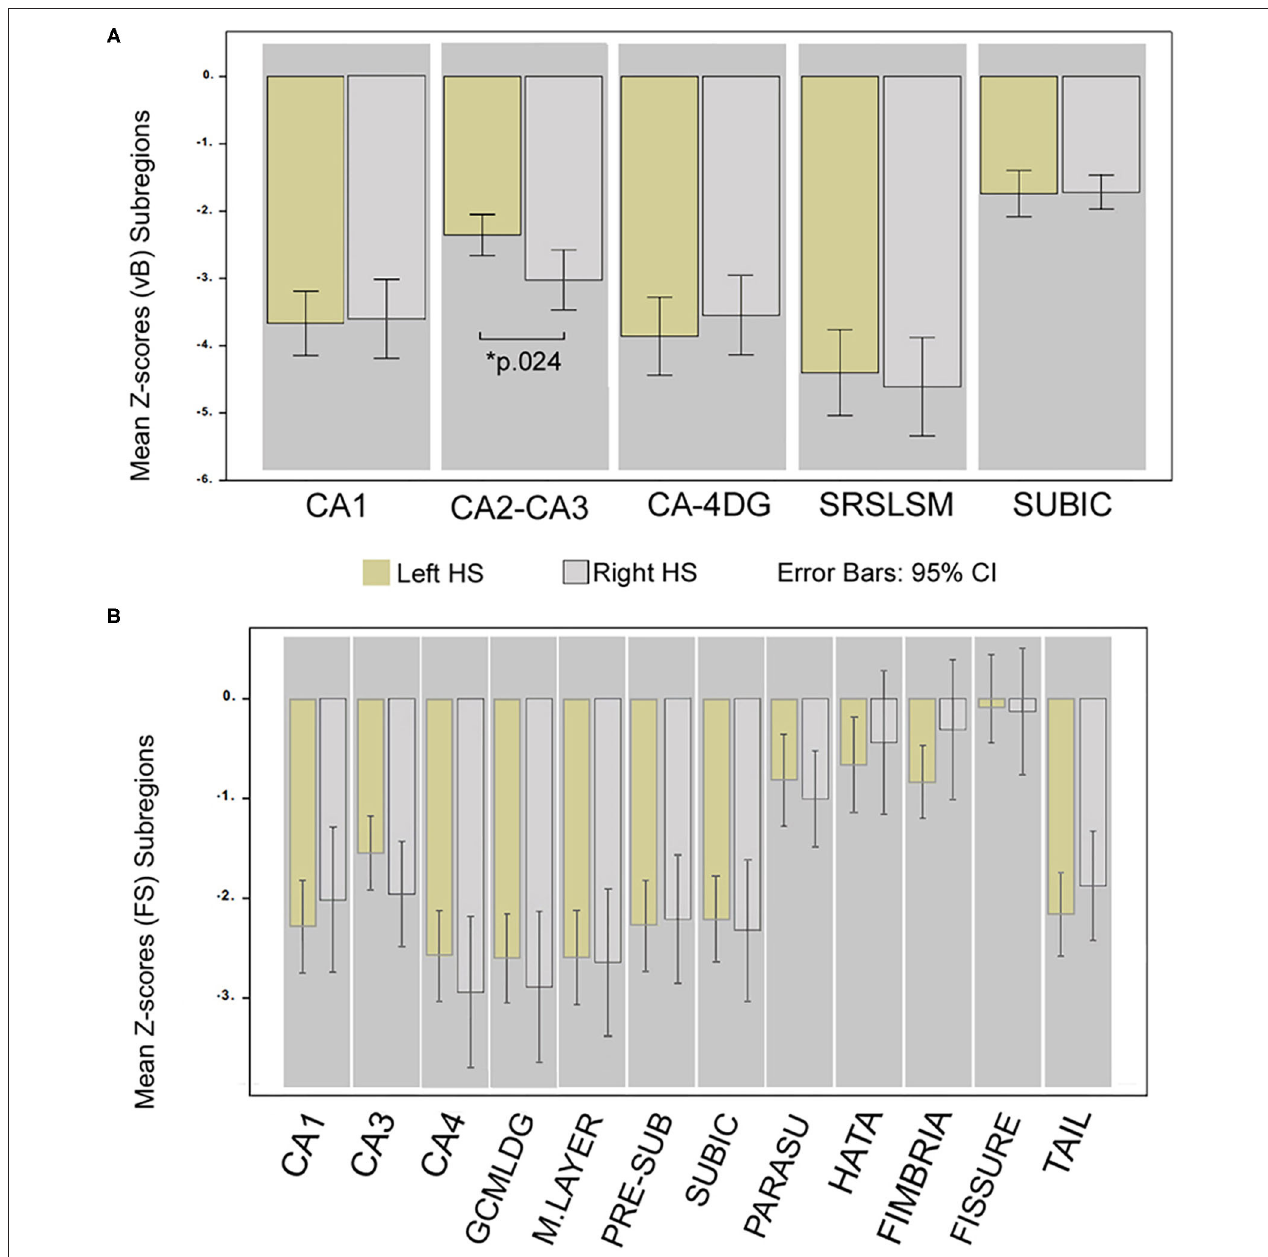
FIGURE 3 | Differences in hippocampal subregion atrophy; comparison of Z-scores between HS sides. Mean Z-score volume comparison between left and right HS; obtained from vB (A) and from FS (B) . *Significant for ANCOVA test between groups; Bonferroni corrected ( p < 0.05) adjusted for age, sex, and epilepsy characteristics. Whiskers represent 95% confidence